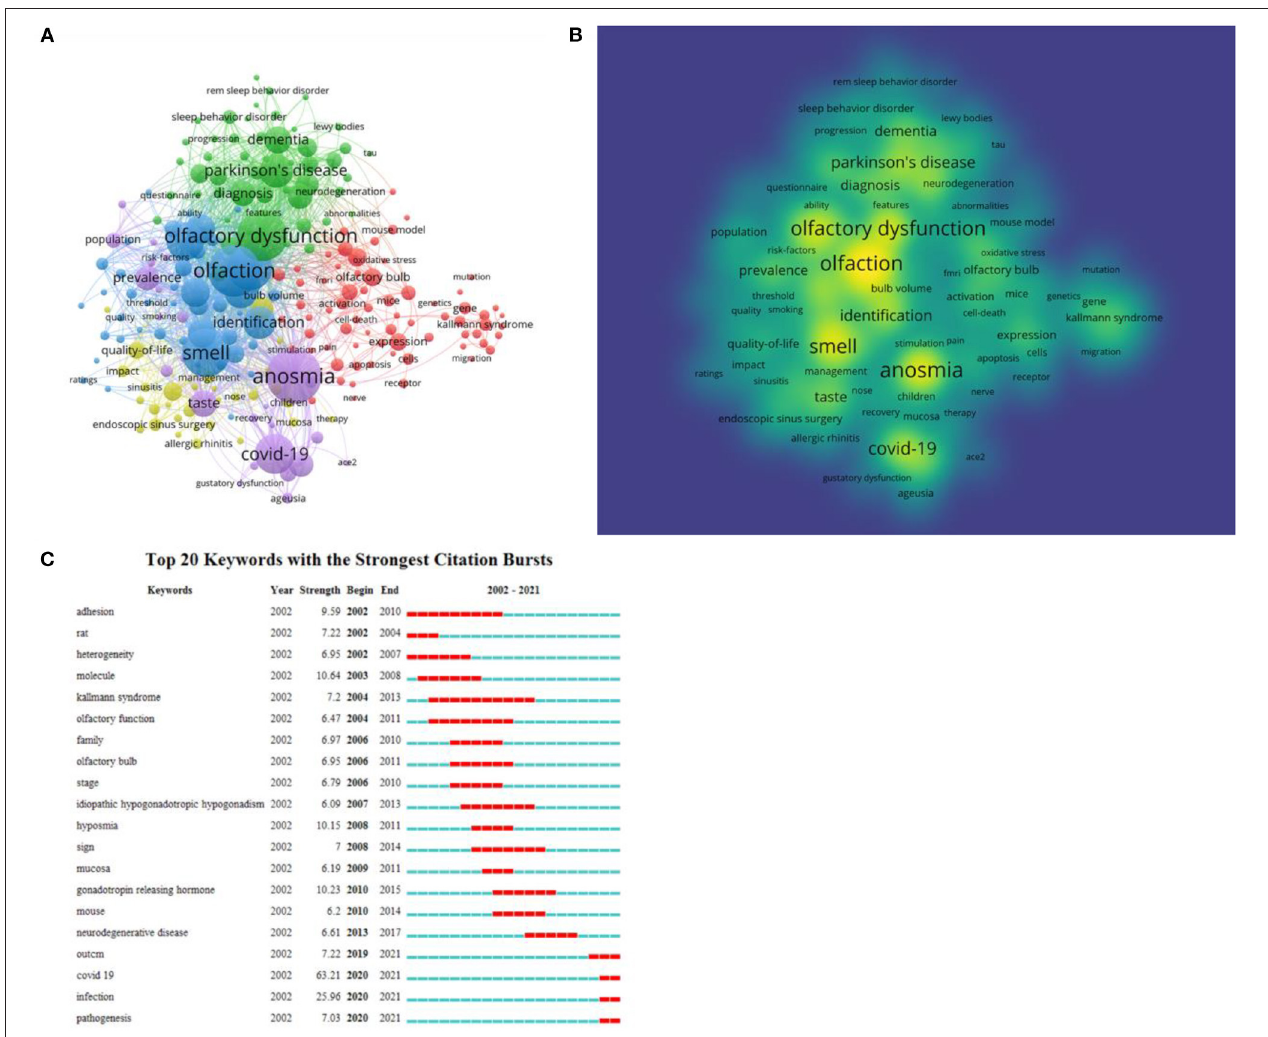
FIGURE 7 | Co-occurrence analysis of global research on olfactory dysfunction published from 2002 to 2021. (A) Mapping of keywords in the research field. (B) Distribution of keywords according to the average frequency of appearance. (C) Keywords with the strongest citation